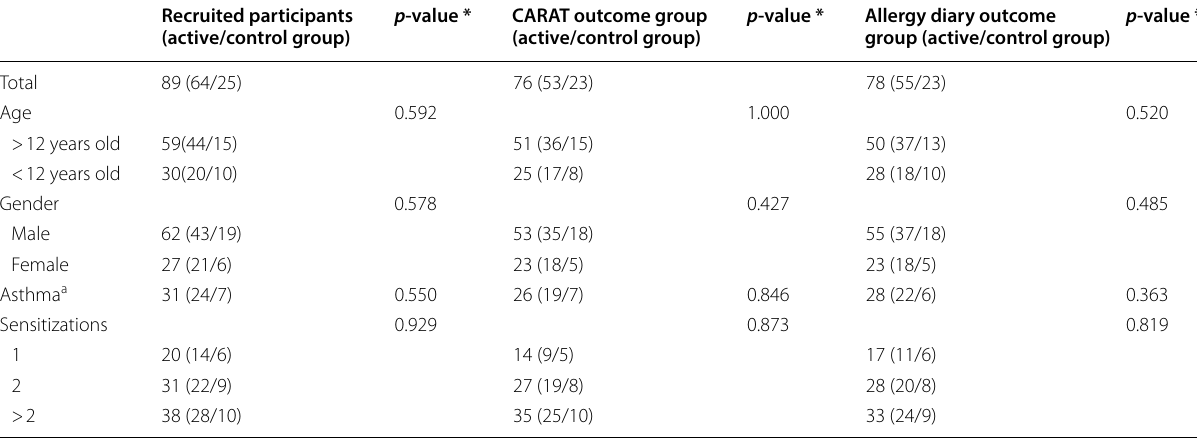
Table 1 Characteristics of the recruited study participants, as well as of the participants with complete CARAT questionnaire and MASK/Allergy Diary results